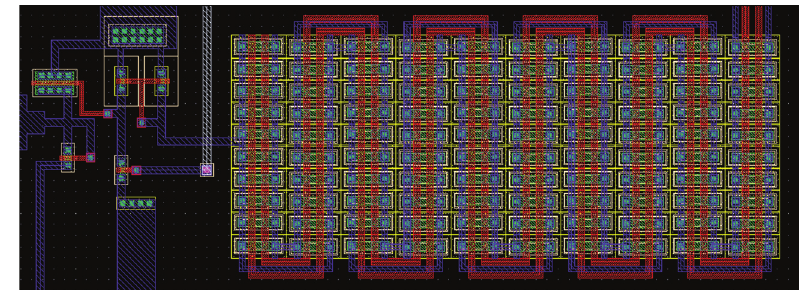
Figure 10: Neural Cell: layout of single point neuron and 10 synapse cells (10 CTS per